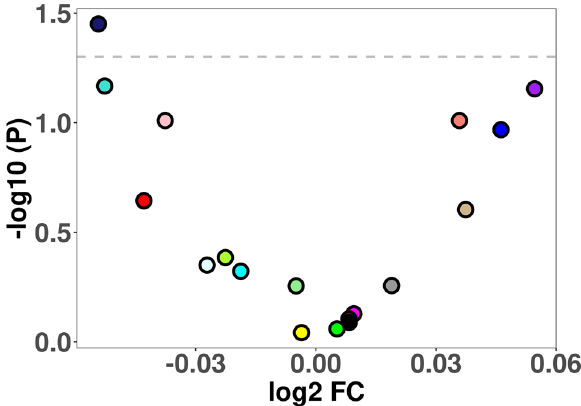
Figure 4. Volcano plot of differential expression of module eigengenes. Module eigengenes were obtained for each co-expression module and used for differential expression between ASD and SIB. The “midnight blue” co-expression module reached nominal significance and was downregulated in ASD patients compared to SIBs. The dashed line indicates p < 0.05 significance level.